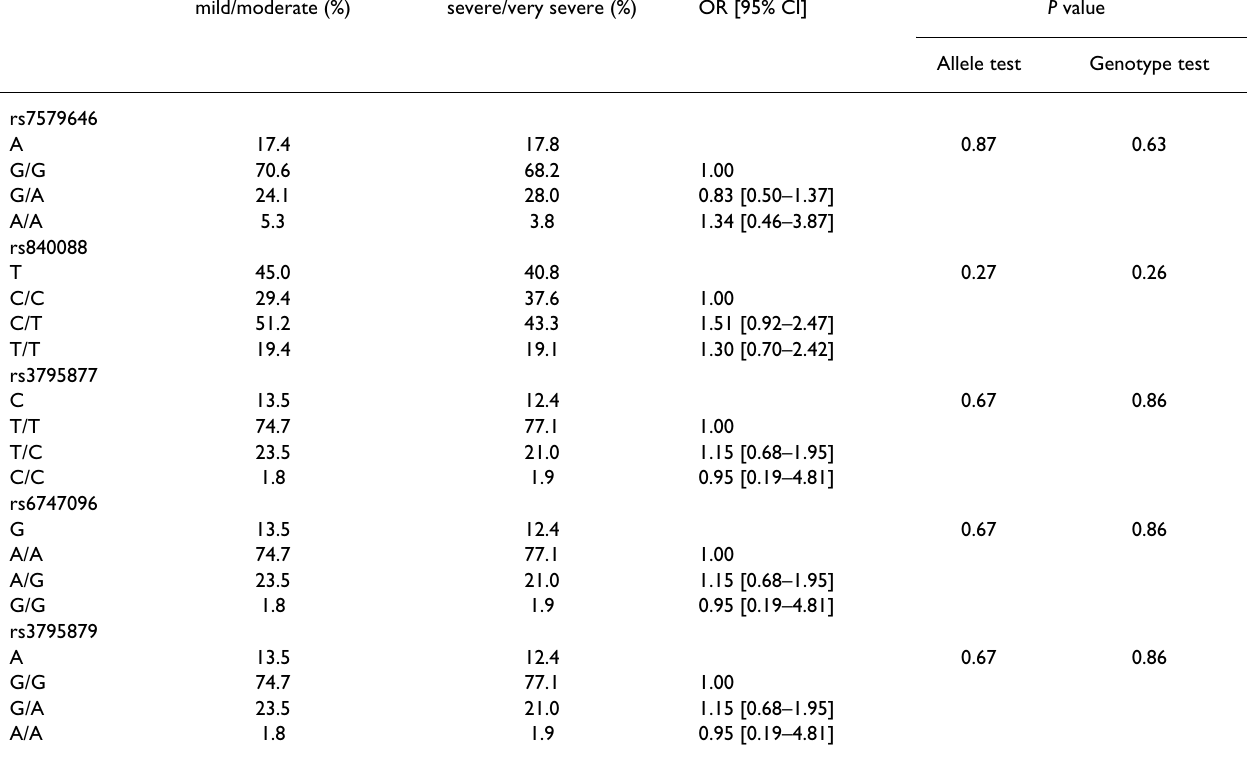
Table 3: Distribution of genotypes and alleles in copd subgroups mild/moderate (%) severe/very severe